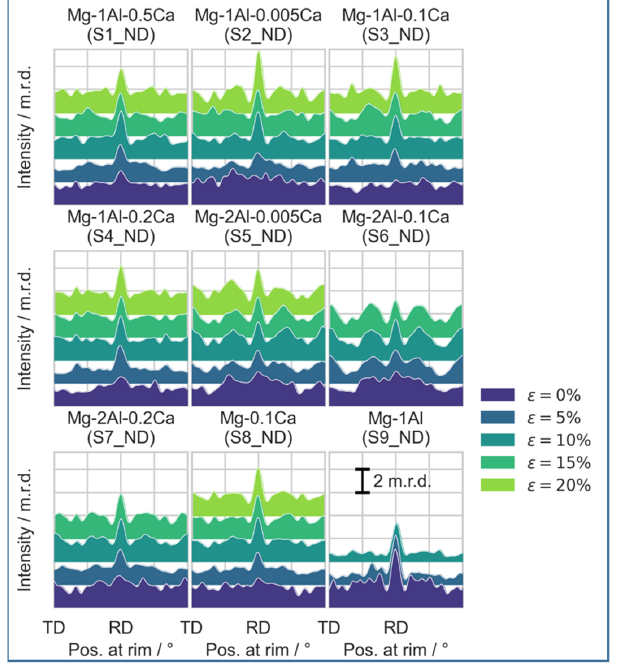
Figure 9. Preferred components for S_TD samples as variation along the rim of the {1010}-pole figures. Distance between TD and RD is 90°.